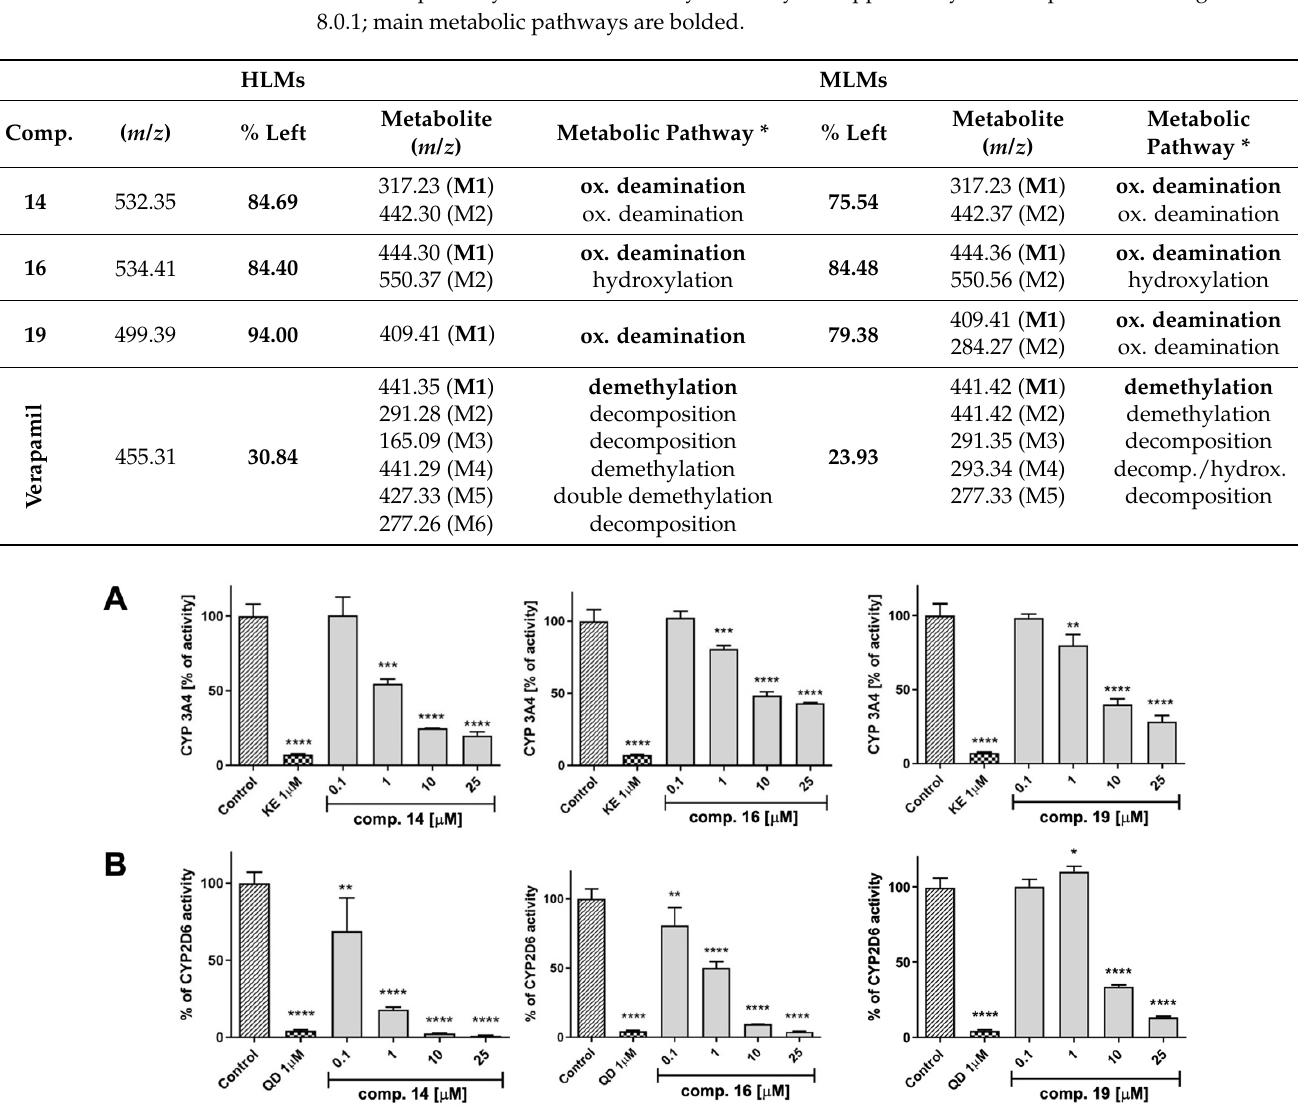
Figure 6. The influence of increasing concentrations of compounds 14 , 16 and 19 (0.1, 1, 10 and 25